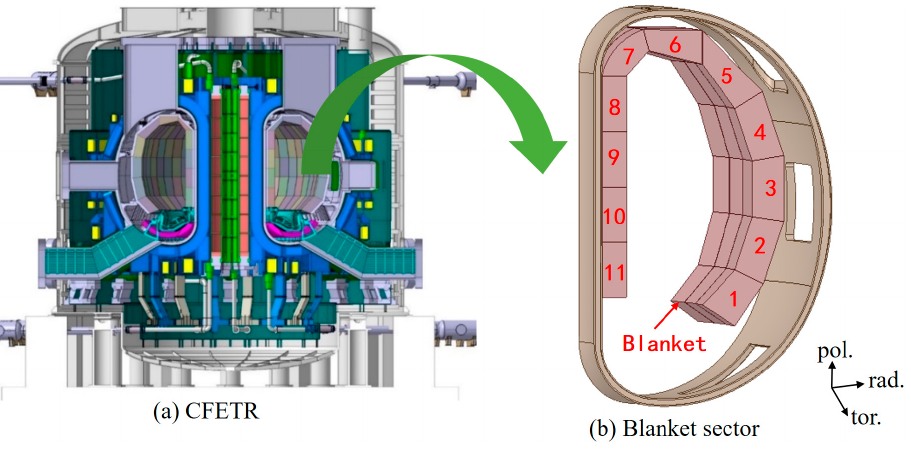
Figure 1. CFETR and blanket layout.